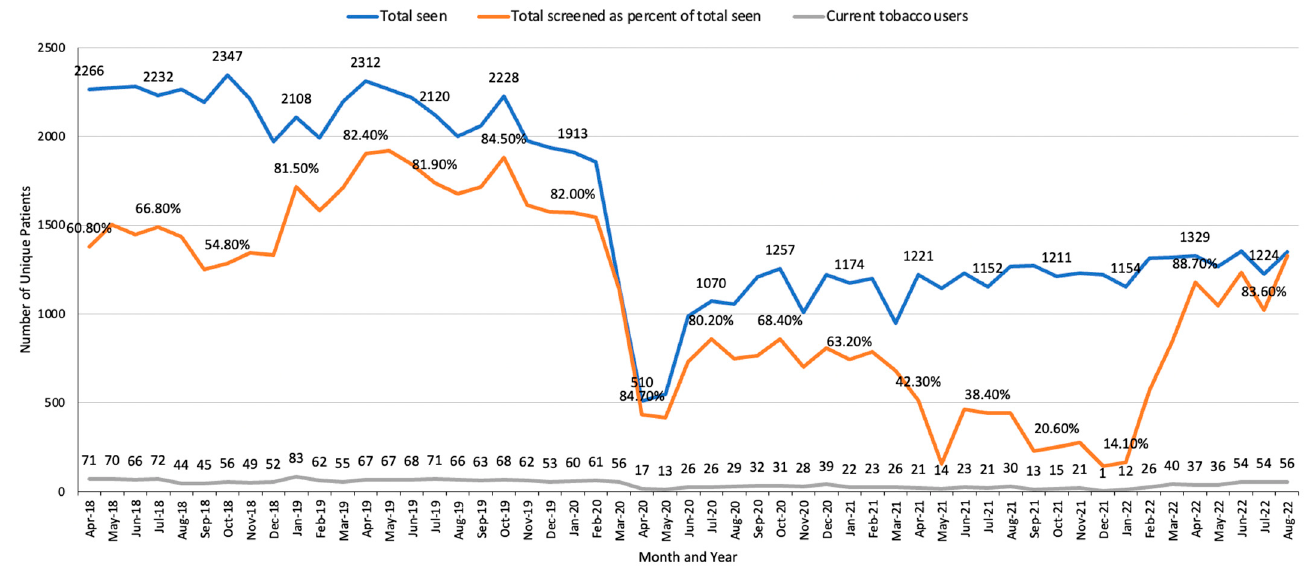
Figure 3. MGUH monthly assessment of the number of unique patients seen in hematology/oncology clinics, percentage of patients screened for tobacco use, and the number of identified tobacco users. Note: patients attending telehealth and lab visits were excluded from this analysis, as MAs were not involved in these visits.